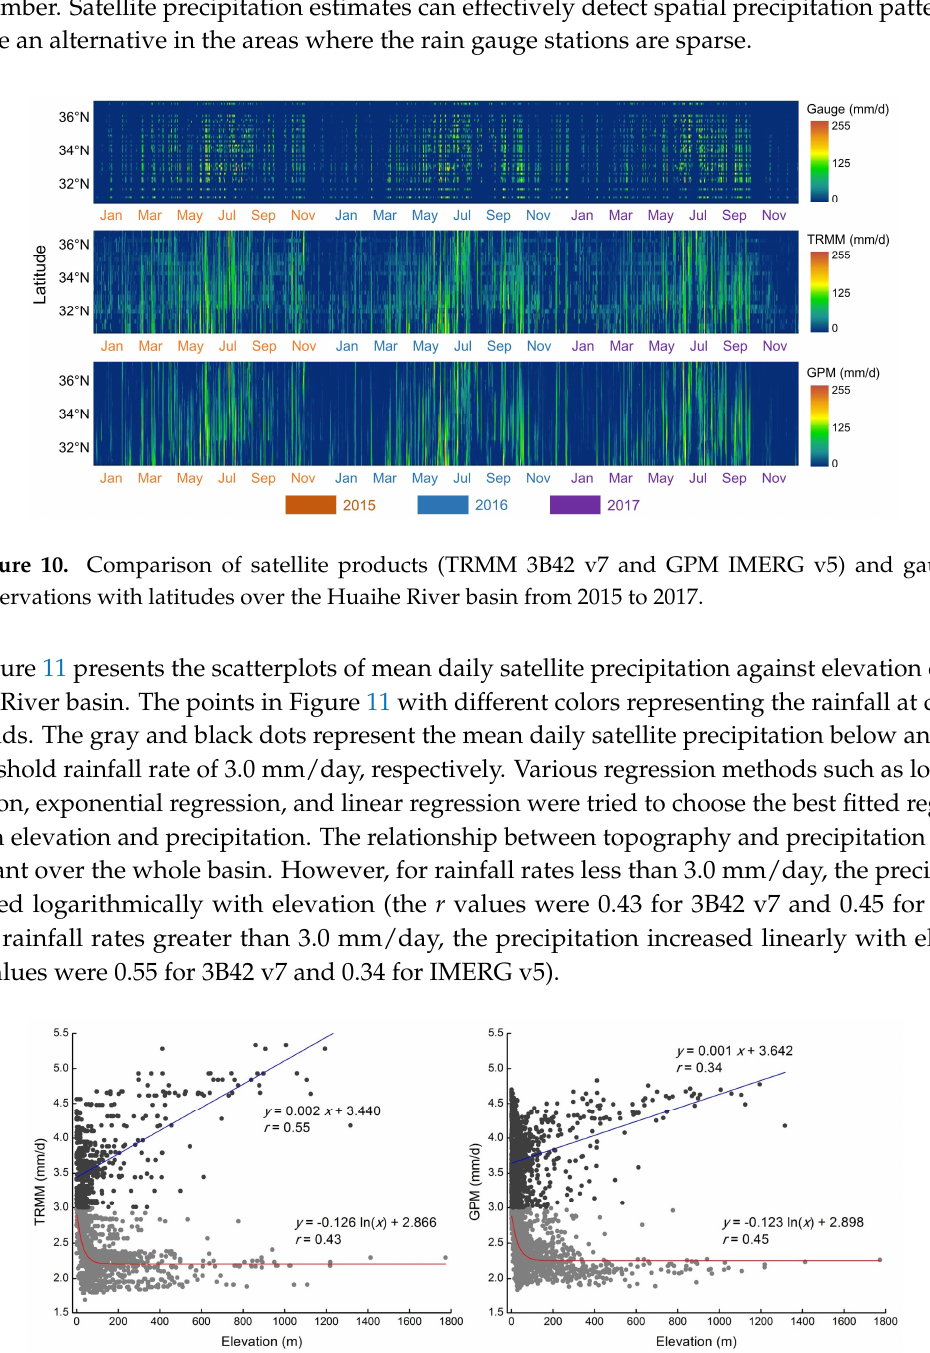
Figure 11. Scatterplots of mean daily precipitation of TRMM 3B42 v7 (a) and GPM IMERG v5 (b) precipitation products against the elevation over the Huaihe River basin.